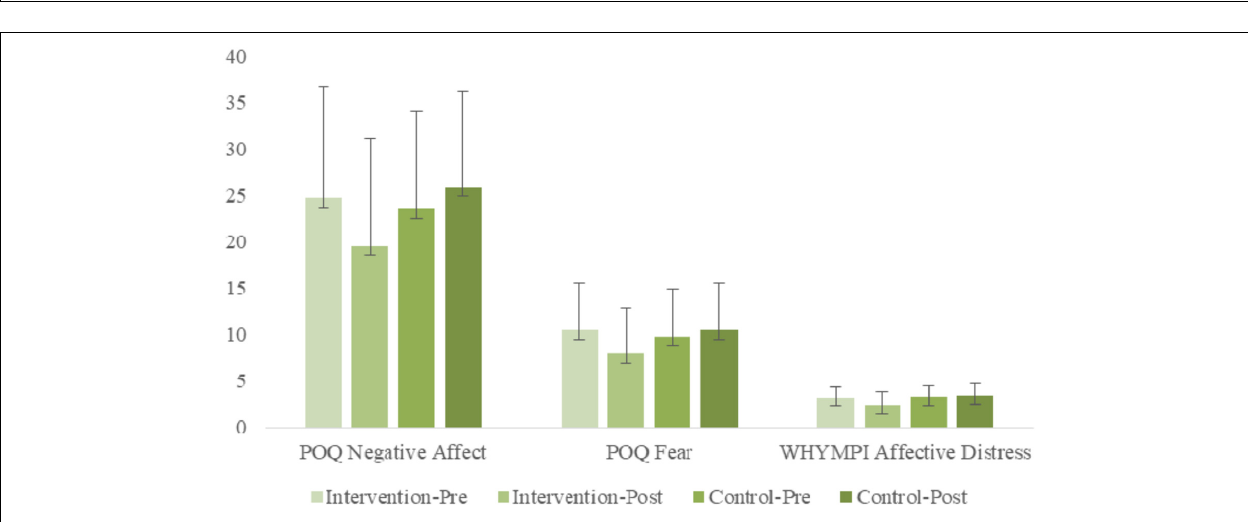
FIGURE 3 | Pre- and post-treatment comparisons of treatment and control groups on WHYMPI Pain Severity-momentary, Total Pain POQ, and SF-36 Total Pain Decrease.